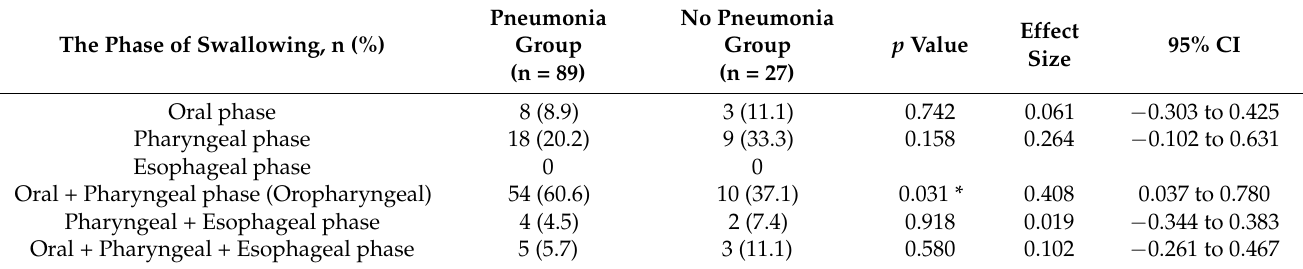
Table 4. Differences in the phase of swallowing between groups.